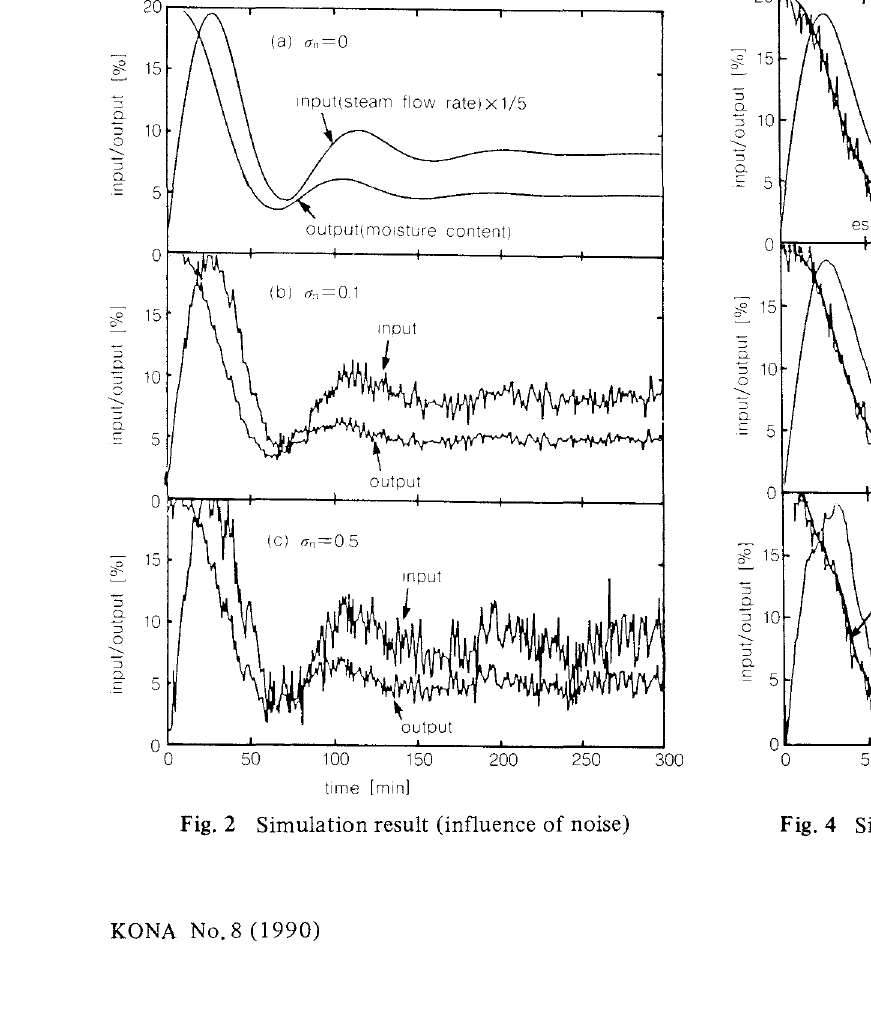
Fig. 4 Simulation result using Kalman